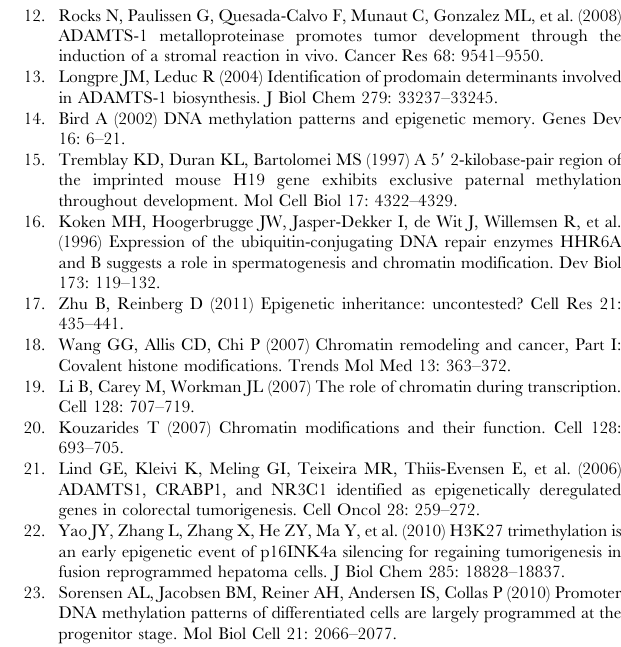
Figure S2 Quality controls for methylated DNA immu- noprecipitation (MeDIP). MeDIP was applied with PCR